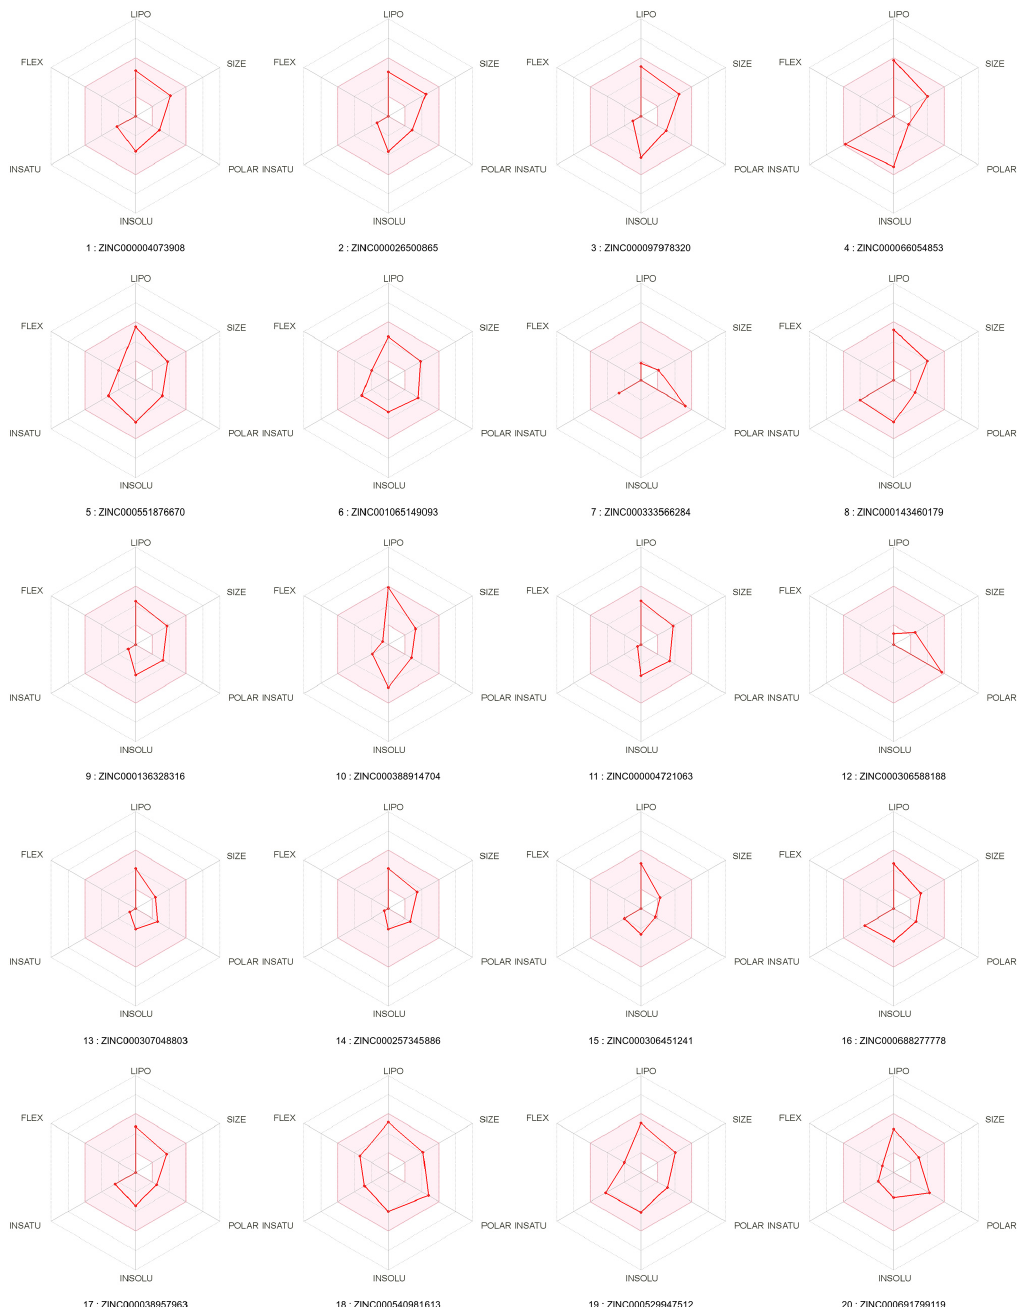
Figure 3. ADME radar plots by SwissADME for oral bioavailability. The pink region represents suitable physicochemical space for oral bioavailability, for each of the six physicochemical parameters and for each of the top 20 ligands presented in this work.